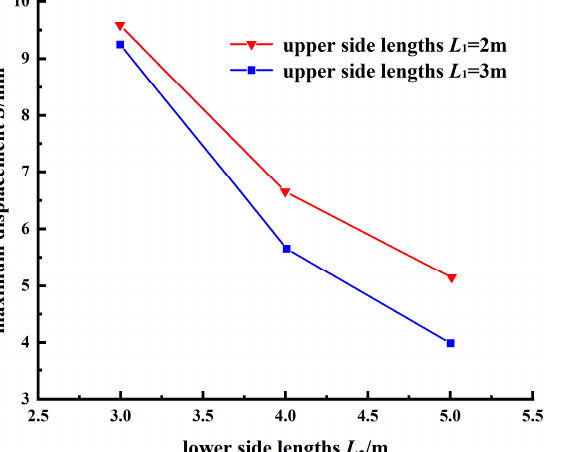
Figure 13. Observation results and numerical results of the portal monitoring point.